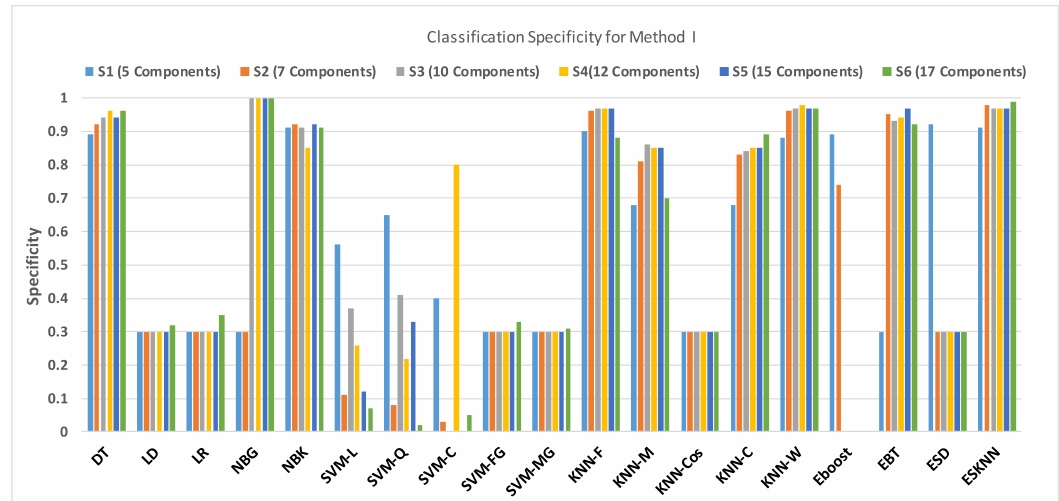
Figure 12. Performance of sensitivity for different feature sets in various classifiers for PuPG signal through method I.